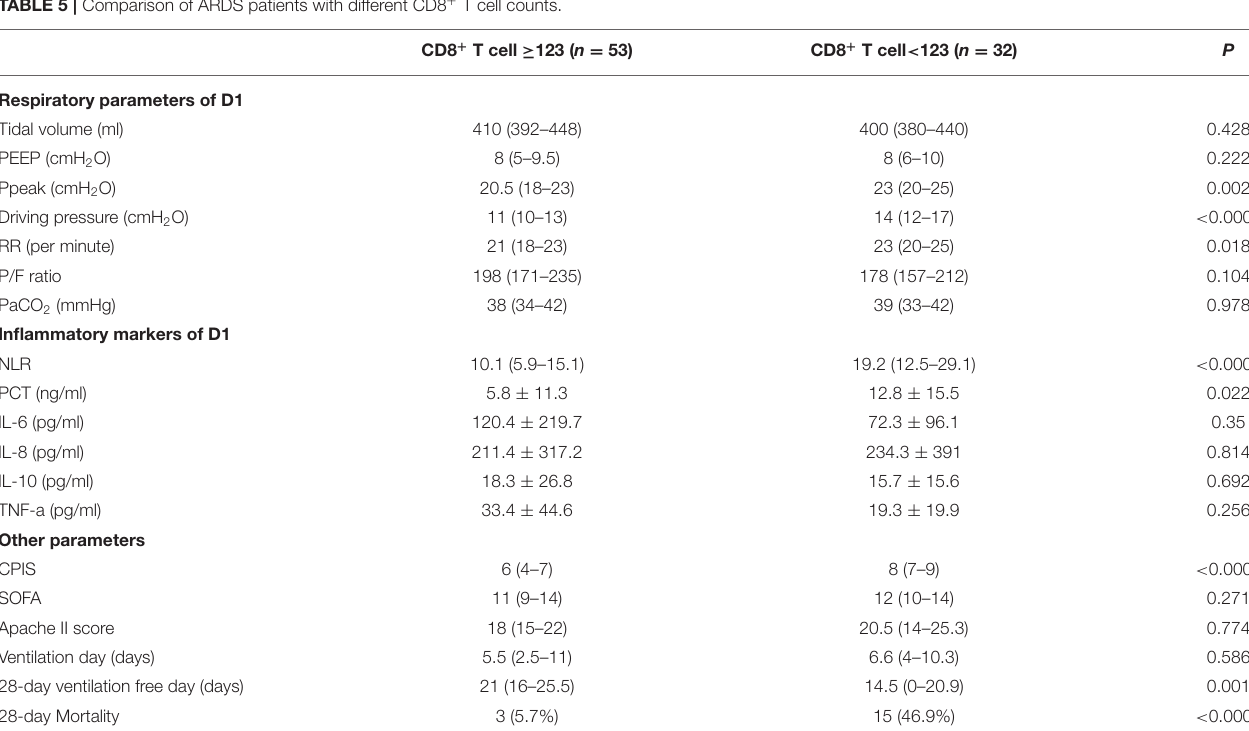
TABLE 5 | Comparison of ARDS patients with different CD8 + T cell